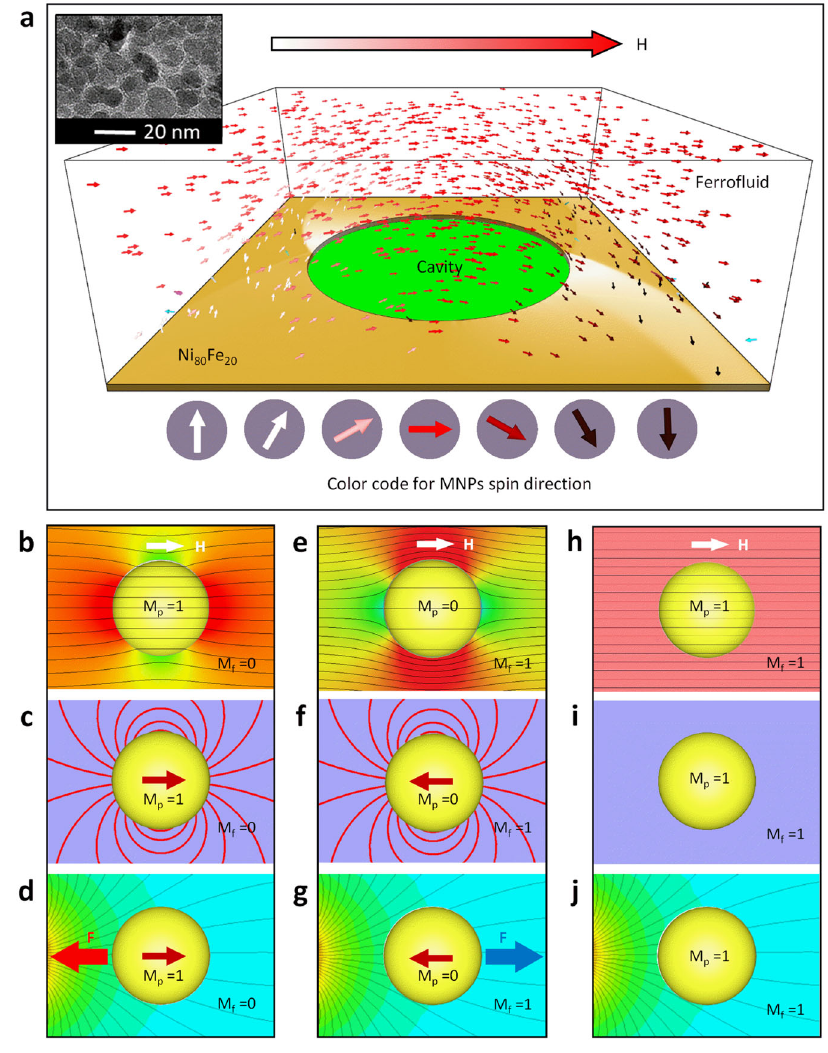
Fig. 2 Simulation results representing particles dipole moment direction in the surrounding fl uid. a The simulated spin directions of Fe 3 O 4 nanoparticles over the negative micro-magnetic disk pattern. The inset presents a transmission electron microscope (TEM) image of nanoparticles with an average size of 10 nm. b , e , h Magnetic fl ux distributions for various magnetization and of a particle in a surrounding fl uid corresponding to a magnetic dipole and a PsD hole, respectively. c , f , i Induced particle dipole moment after subtracting the applied magnetic fi eld, revealing magnetic dipole, PsD dipole, and no dipole moment, respectively. d , g , j Magnetic force direction under non-uniform magnetic fi elds for various magnetization and of a particle in a surrounding fl uid corresponding to a magnetic dipole and a PsD hole,